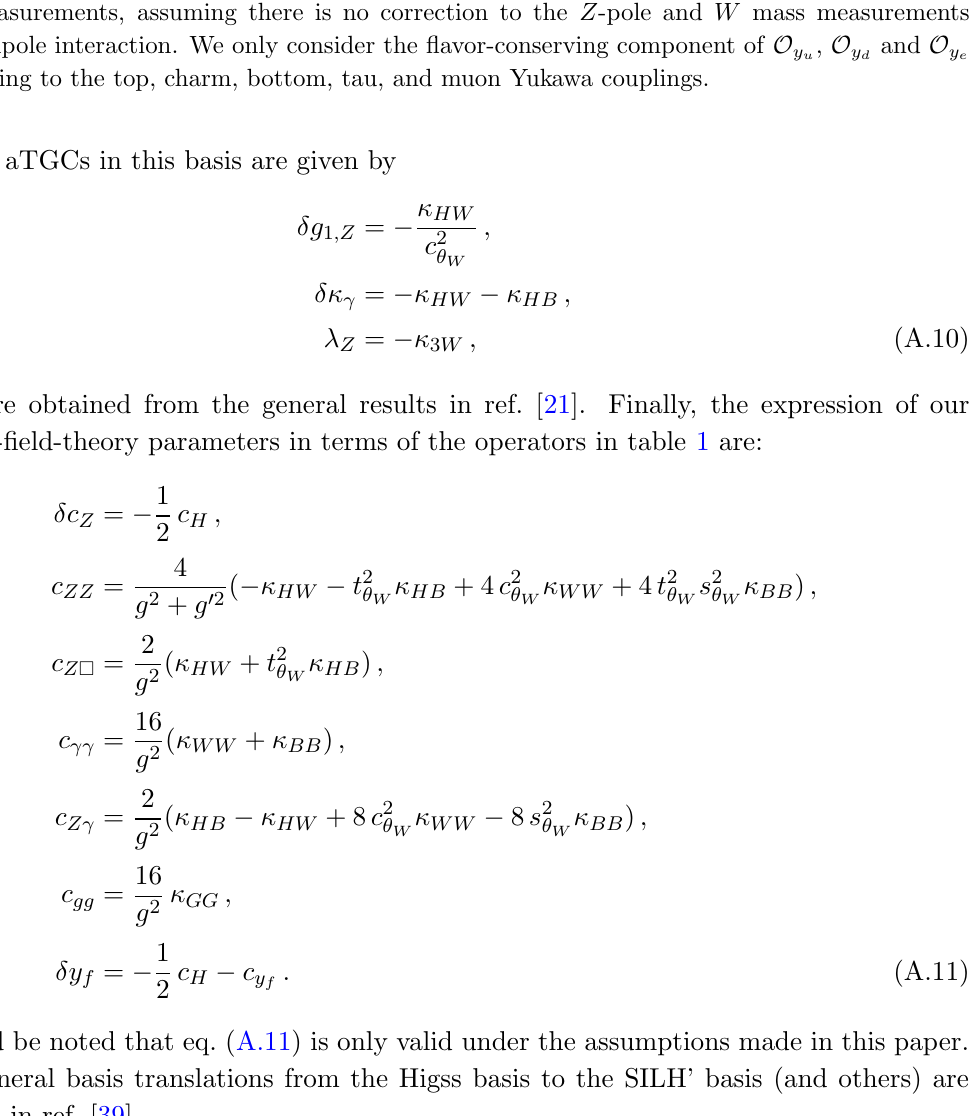
, and O y u O y d O y e